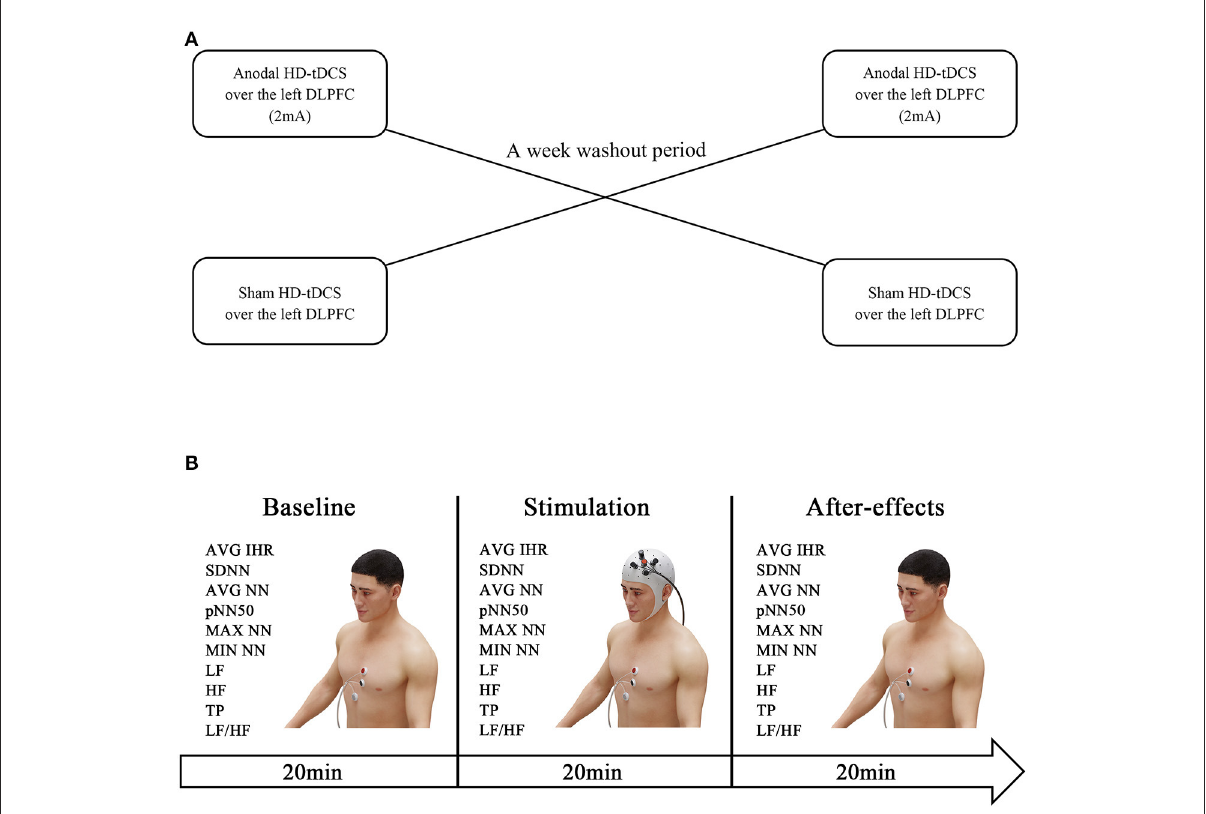
FIGURE1 Experiment design. The HR and HRV data were measured at baseline (20min before the HD-tDCS session). Subsequently, the participants were randomized to receive anodal HD-tDCS (2mA) or sham HD-tDCS over the left DLPFC, and electrocardiogram recordings were obtained throughout the intervention. One week later, the interventions were swapped (A) . The after-effects were measured by evaluating the HR and HRV within 20min post-treatment (B)